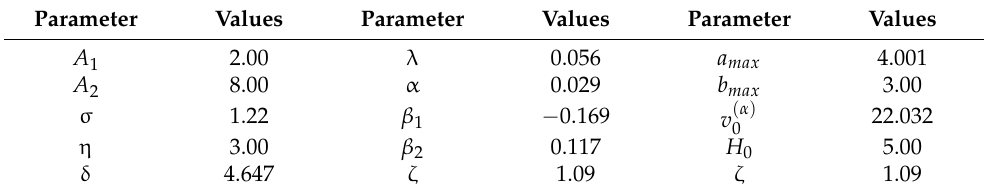
Table 2. Parameter values